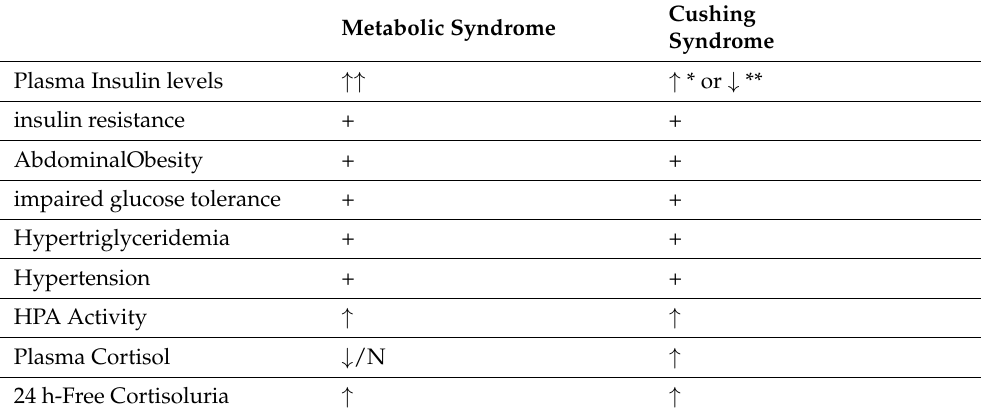
Table 1. Overlap and differences in clinical characteristics between the metabolic syndrome and Cushing